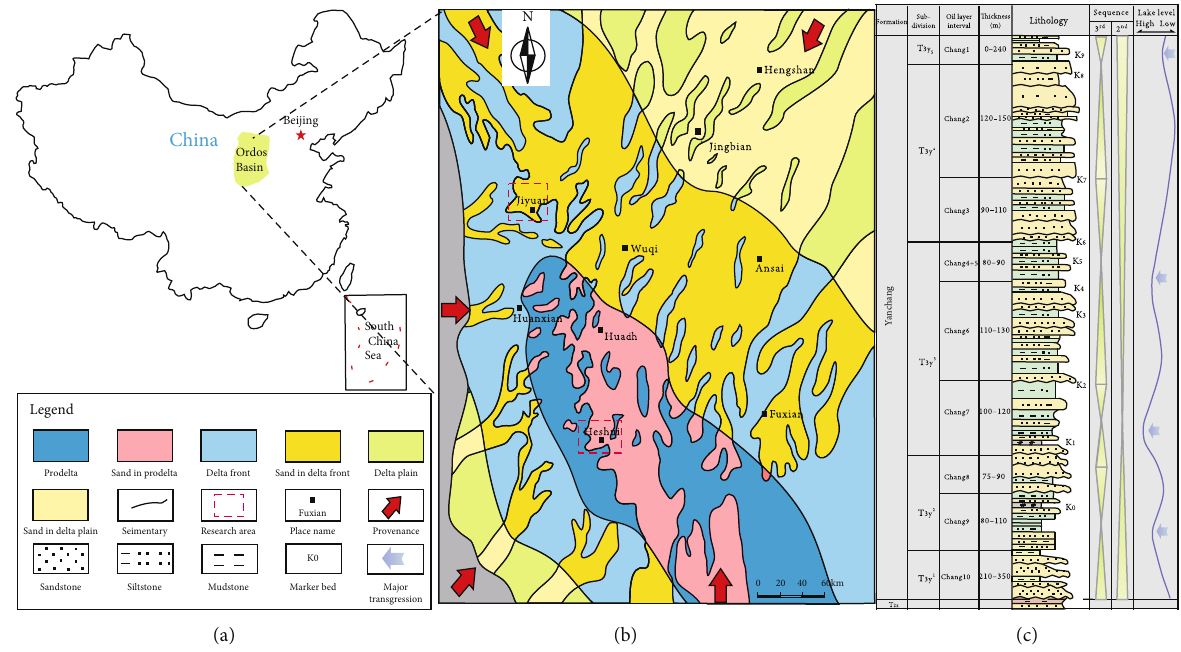
Figure 1: Geographic location and depositional setting in the research zone (modi fi ed from [14]).